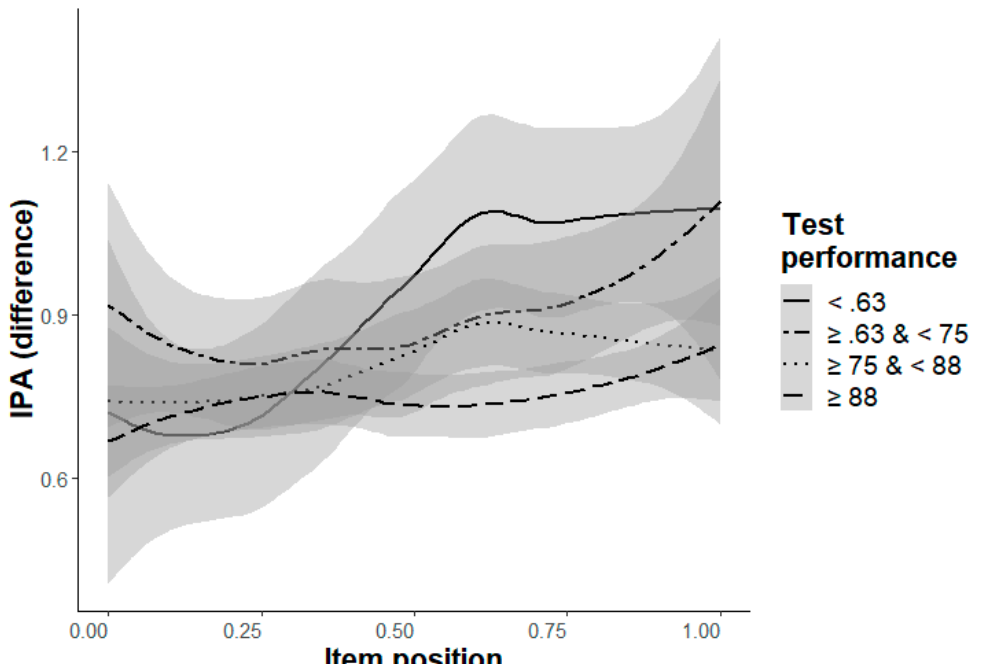
Figure 6. Changes of IPA (difference) depending on the item position (x-axis) and the test performance (ACC-poss, grouped in four intervals, indicated by four lines) with .95-confidence-interval for Level e. The four test performance groups consisted of N = 11 (ACC-poss < .63), N = 23 ( ≥ .63 and <.75), N = 44 ( ≥ .75 and <.88), N = 63 ( ≥ .88) participants. Notice, larger values of IPA (difference) indicate lower cognitive workload, and the item position is standardized with the range 0 (1st item) to 1 (24th item).